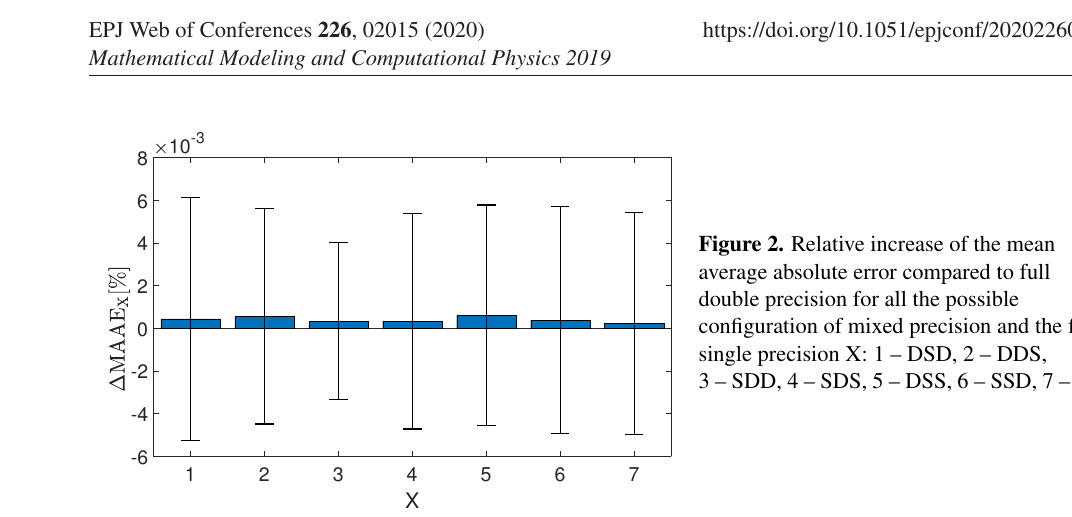
Figure 2. Relative increase of the mean average absolute error compared to full double precision for all the possible configuration of mixed precision and the full single precision X: 1 – DSD, 2 – DDS, 3 – SDD, 4 – SDS, 5 – DSS, 6 – SSD, 7 – SSS